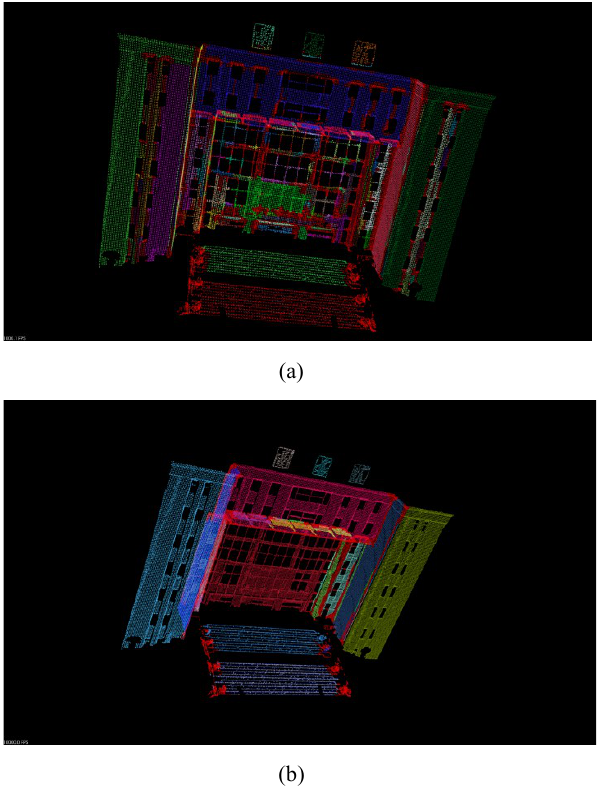
Figure 3. Point cloud segmentation experiment